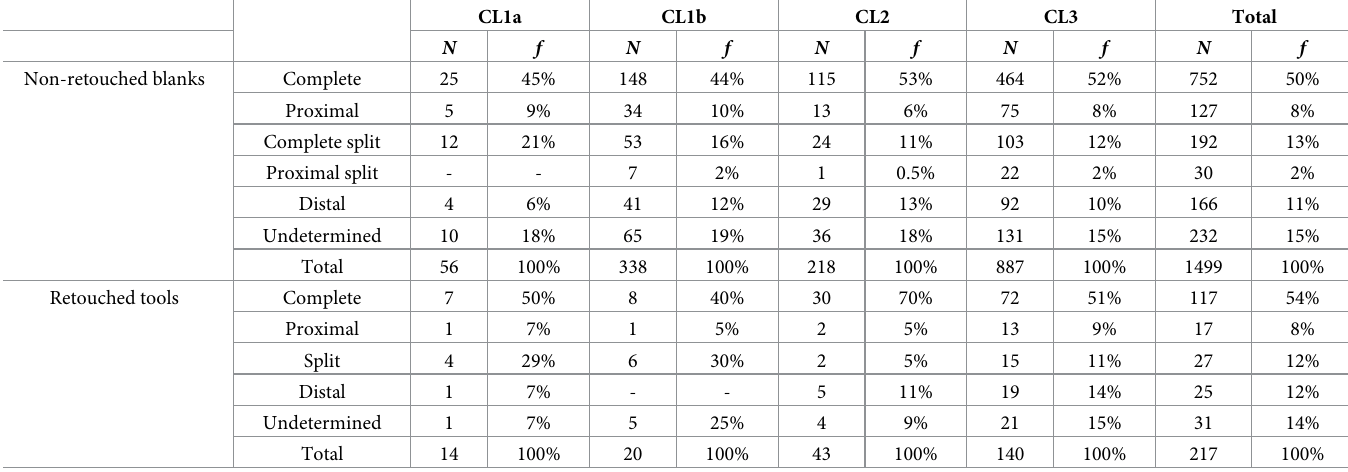
Table 2. The frequency of blanks and tools.